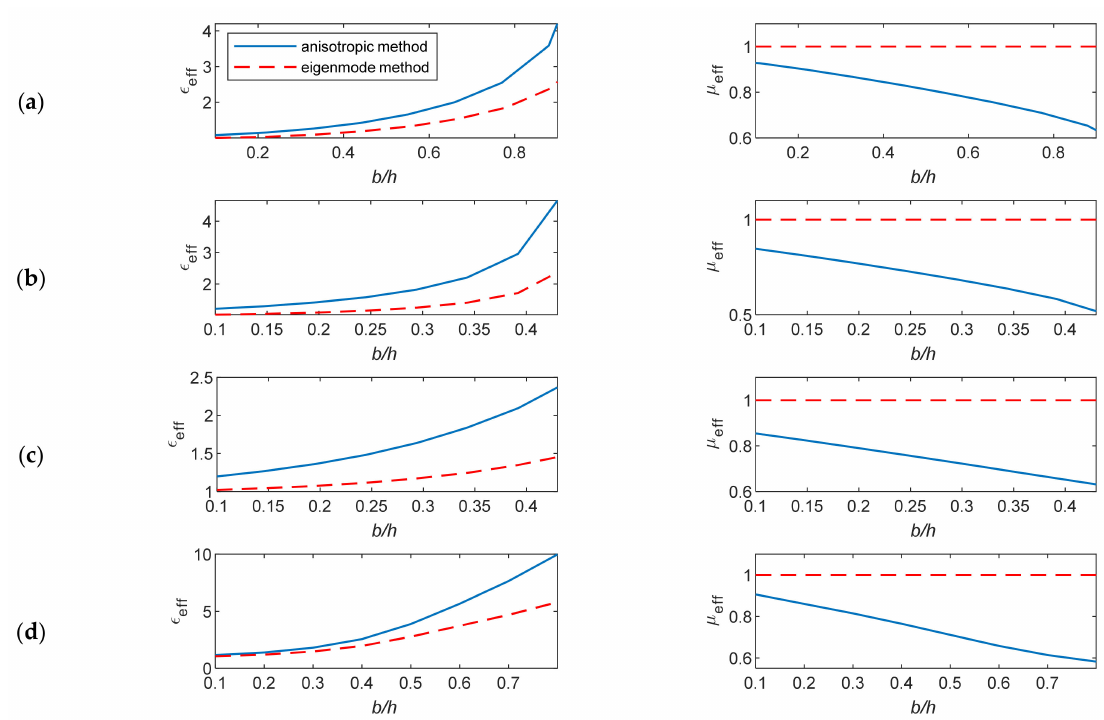
Figure 6. The extracted ε eff and µ eff versus the ratio b/h for the unit cells A , B , C and D . ( a ) Unit cell A , ( b ) unit cell B , ( c ) unit cell C , and ( d ) unit cell D .